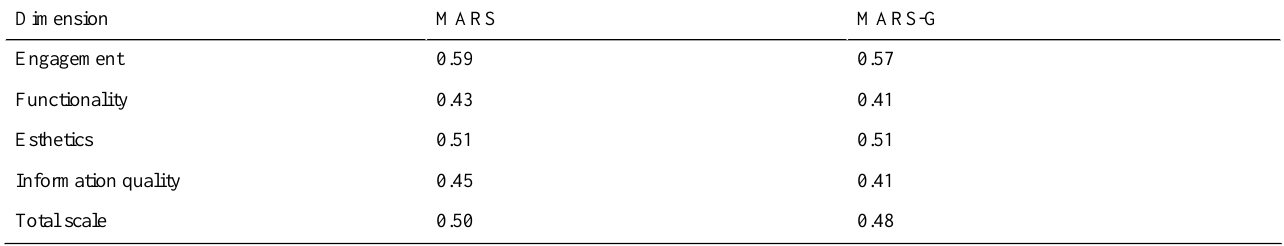
Table 3. Summary of the Hk coefficient (overall scalability of all items in the scale) for the Mobile App Rating Scale (MARS) and the German version of the Mobile App Rating Scale